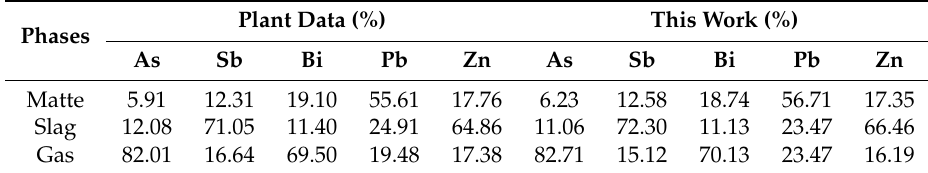
Table 8. Comparison of predictions with actual plant data of the minor elements distributions in SKS process.